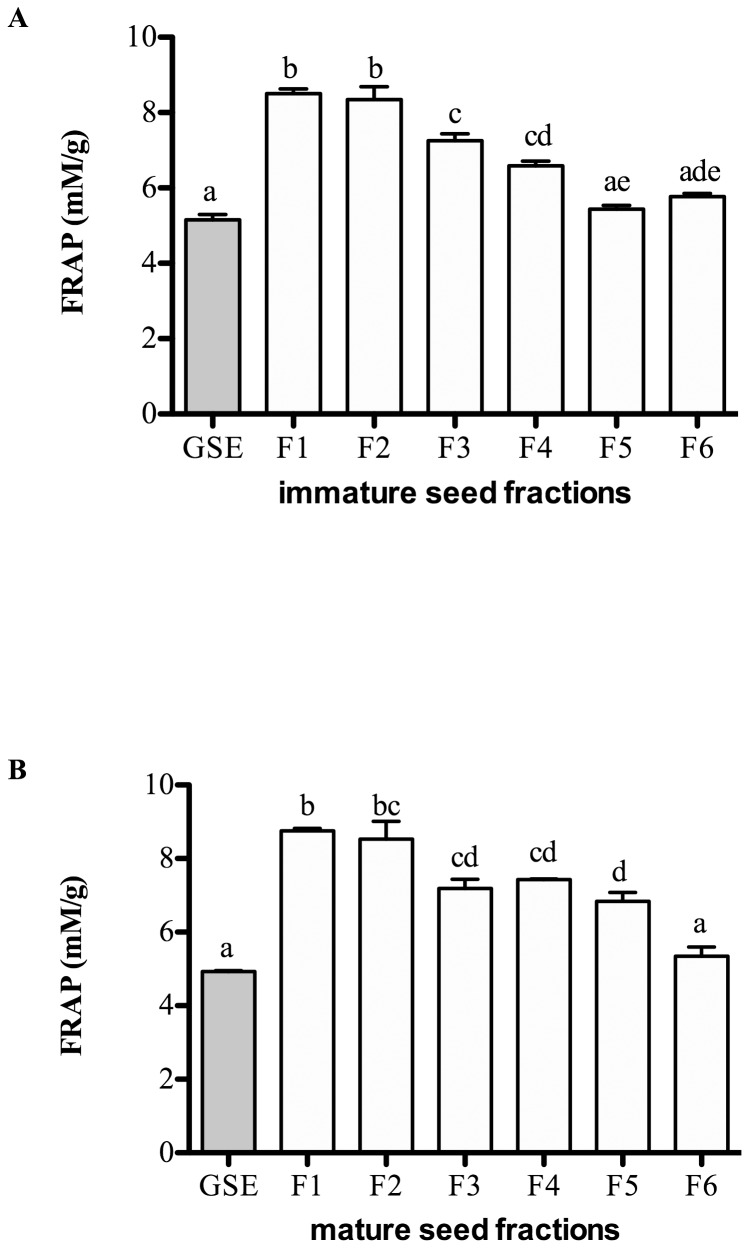
Antioxidant activity of the fractions from immature (A) and mature (B) seed extracts measured by Ferric reducing antioxidant power (FRAP) assay.Results are expressed as mean ± SEM of 3 independent experiments. Statistical analysis was determined by one-way ANOVA with Tukey'spost-hoc test. Values with different letters (a,b,c) in each column are statistically different at P<0.05.